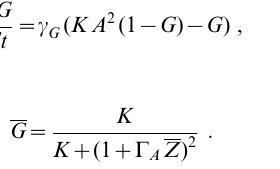
Parameter Act. dimer.